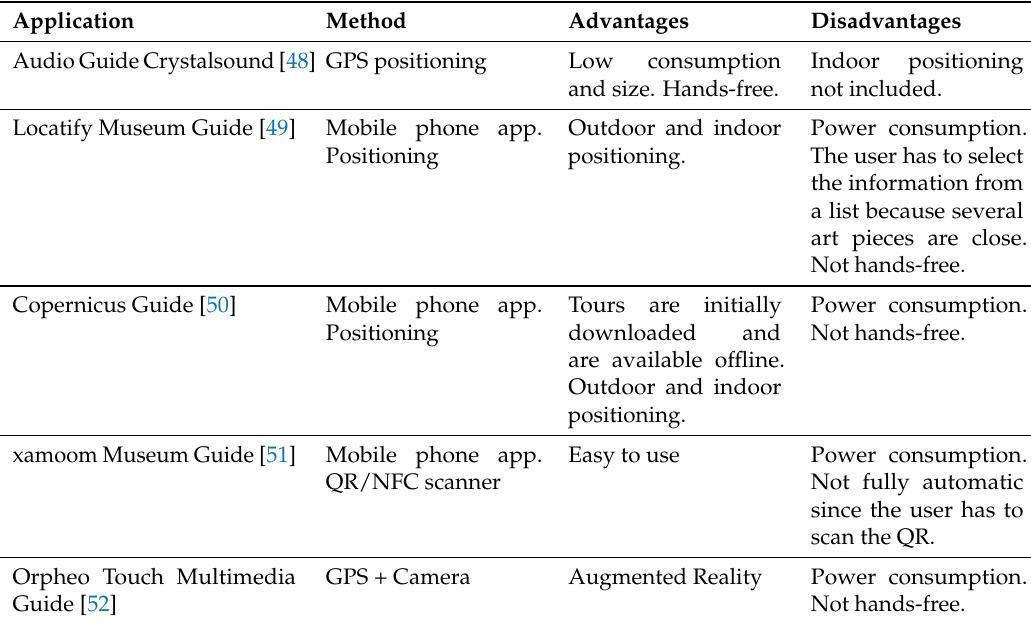
Table 1. Comparison of existing